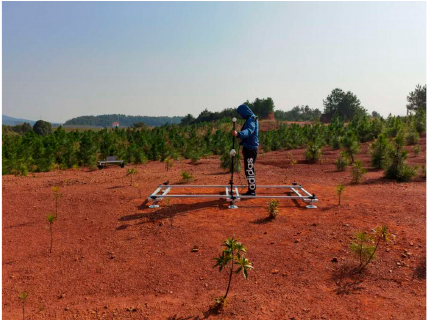
Figure 18. The calibration of the geomagnetic field.